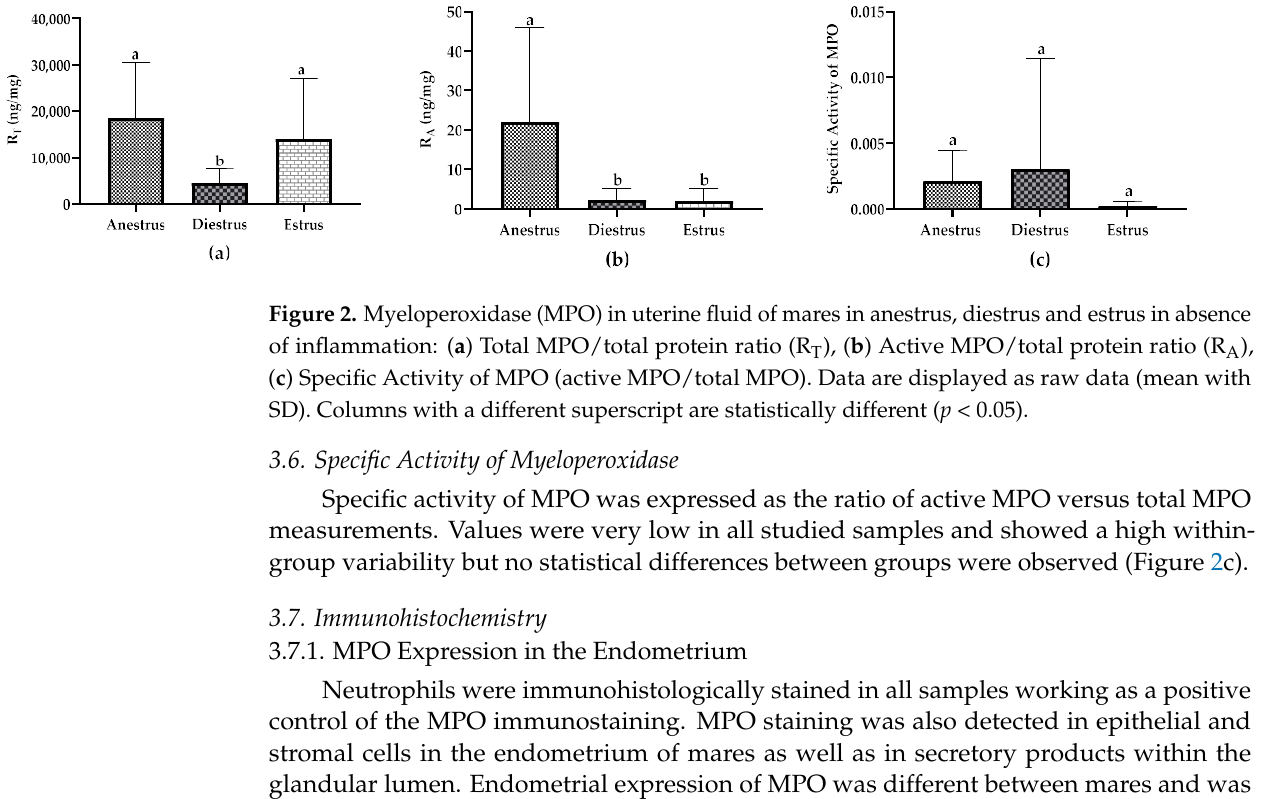
Figure 1. Association between total protein concentration and total and active myeloperoxidase (MPO) levels in uterine lavages in mares in the studied phases: anestrus, diestrus and estrus. p val- ues < 0.05 are considered as significant.